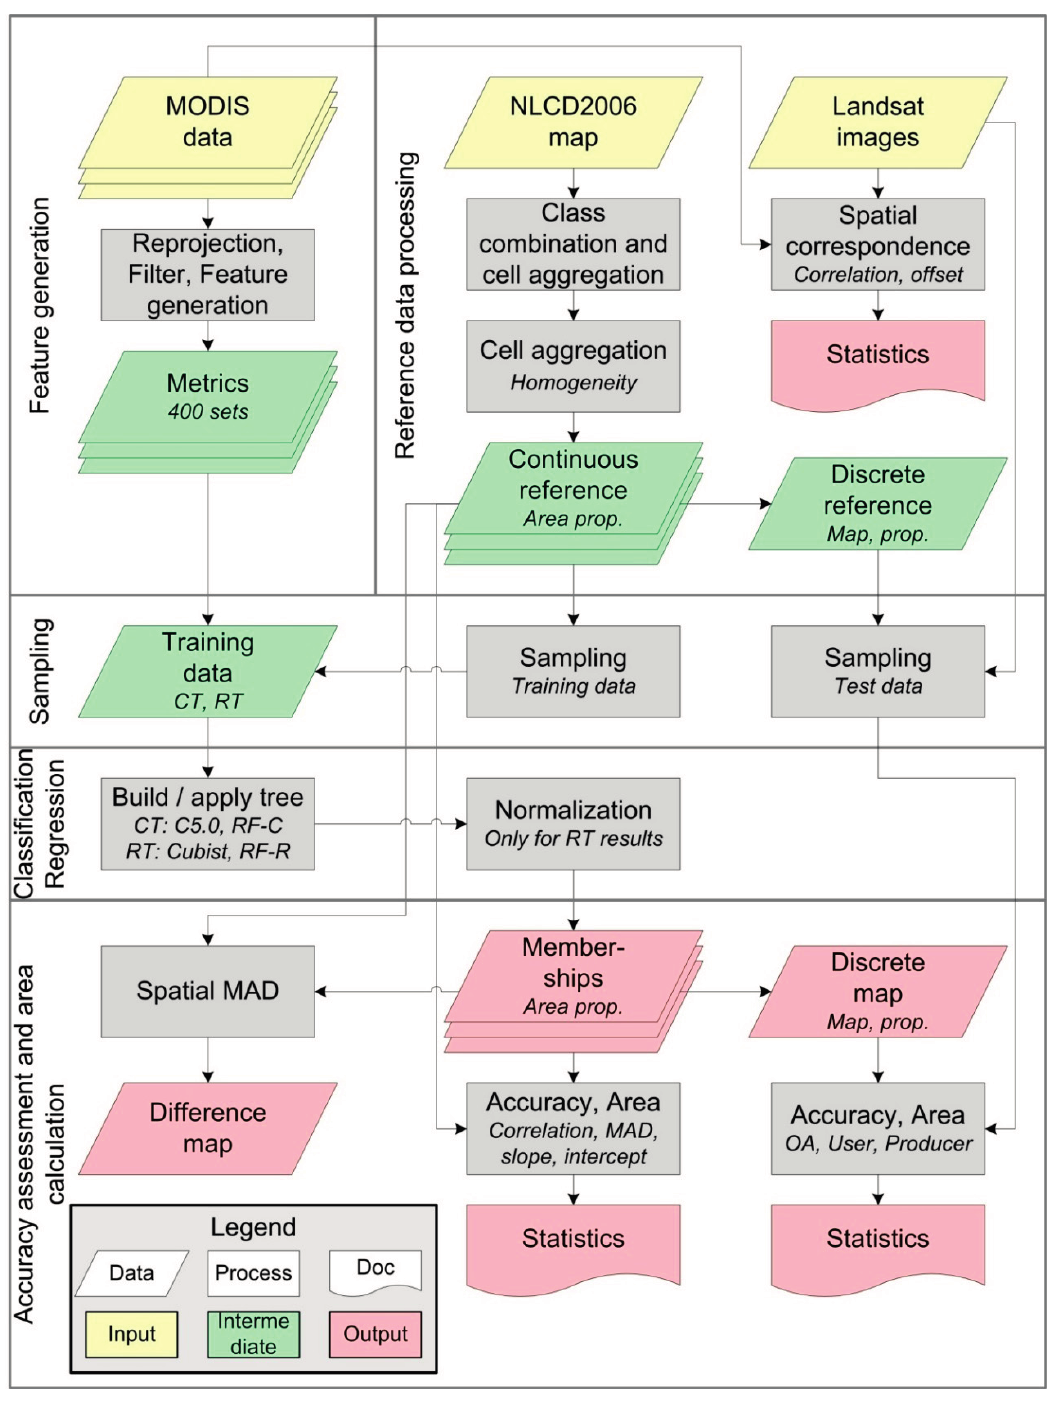
Figure 2. Process-flow for data processing and map assessment. OA: overall accuracy, MAD: mean absolute difference, CT: classification tree, RT: regression tree, RF-C: Random Forest Classification, RF-R: Random Forest Regression, prop: